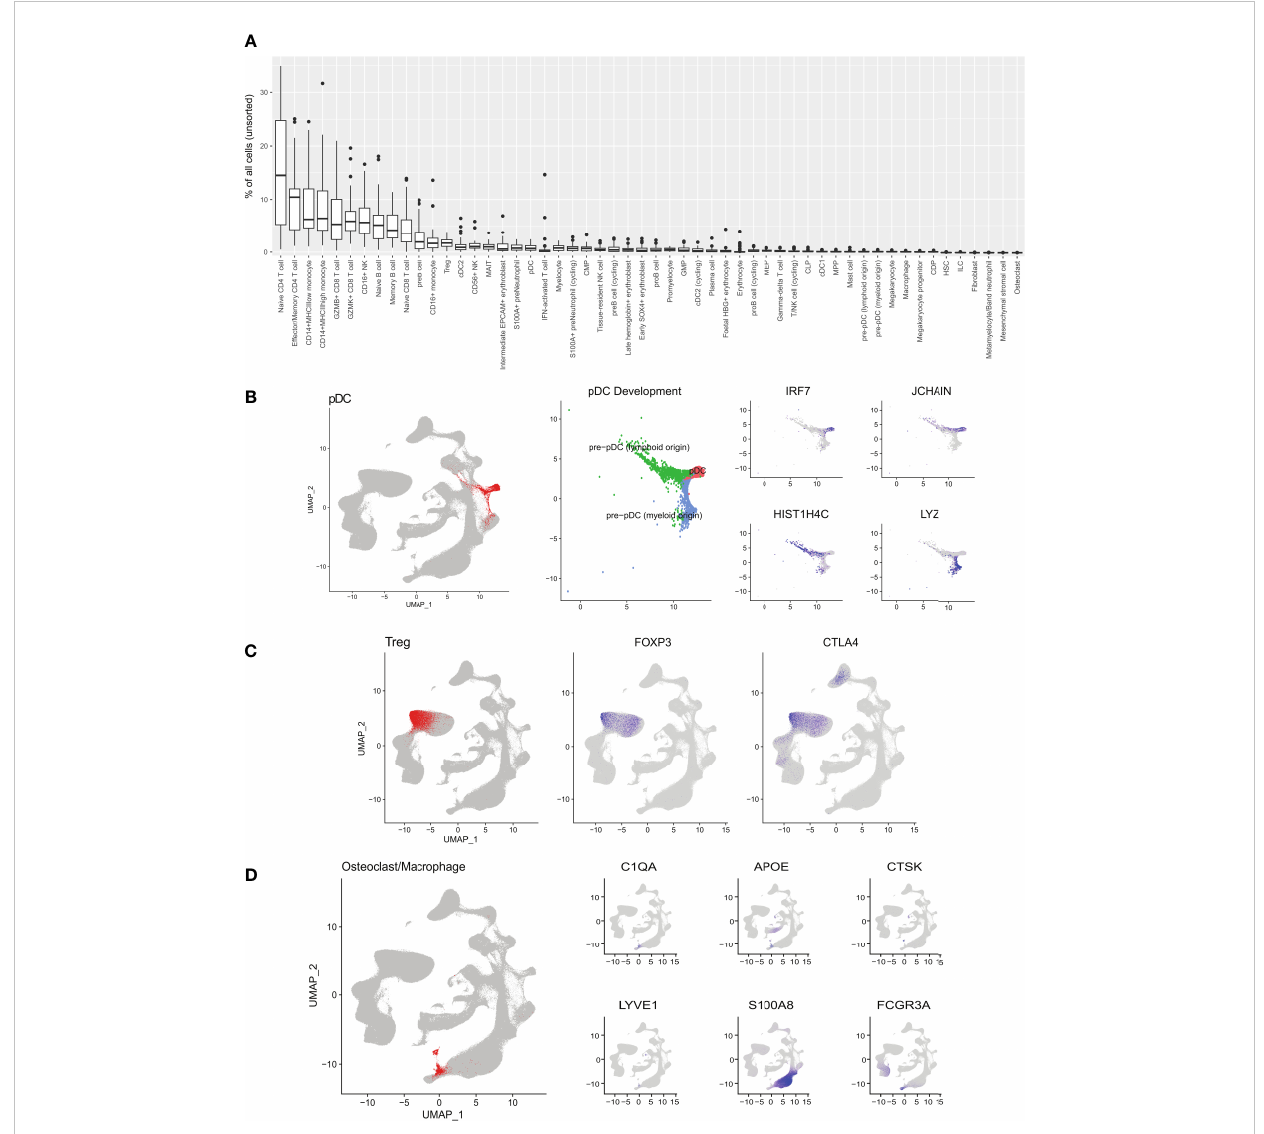
FIGURE 2 Detailed cell type populations and annotation. (A) Percentage of cells for each cell type in unsorted bone marrow samples. (B) pDC development pathways of myeloid and lymphoid origins. (C) Treg cell population identi fi ed by canonical markers. (D) Osteoclast/macrophage cells identi fi ed by canonical